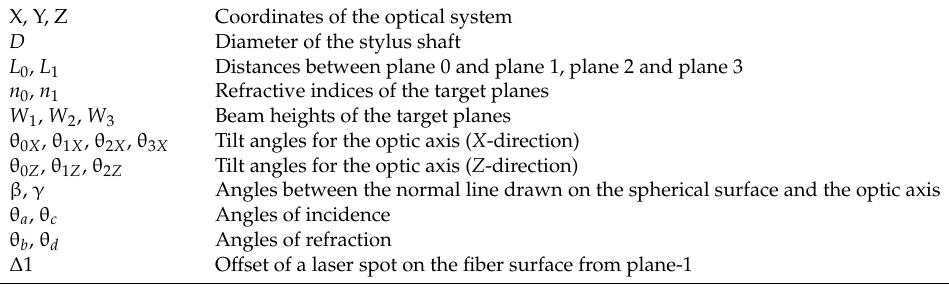
Figure 3. Ray trajectory in the optical system. Table 2. Nomenclature used for simulation calculations.